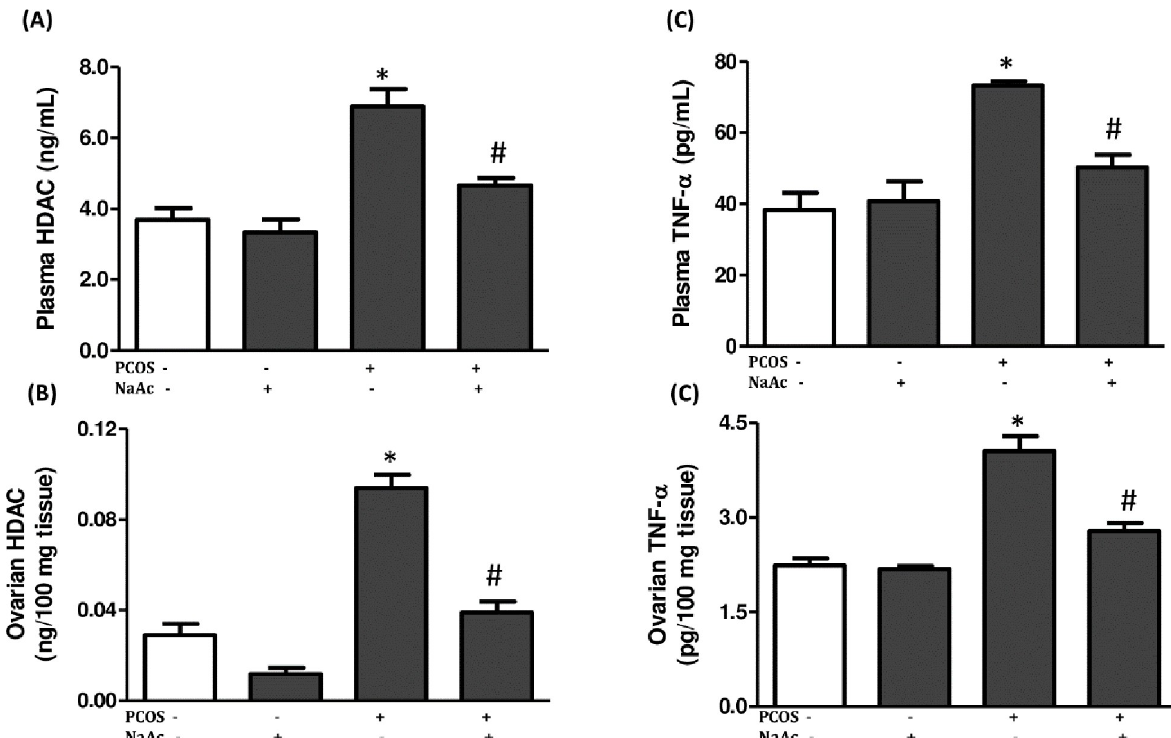
Fig 6. Impact of sodium acetate on plasma and ovarian histone deacetylase (a, b) and tumor necrosis factor- α (c, d) in LET-induced PCOS rat model. Data are expressed as mean ± SD. n = 6. Data were analyzed by one-way ANOVA followed by Bonferroni post hoc test . ( � p < 0.05 VS. CTL; # p < 0.05 VS. PCOS). Control (CTL); Polycystic ovarian syndrome (PCOS); Sodium acetate (NaAc); Histone deacetylase (HDAC); Tumor necrosis factor- α (TNF- α ).